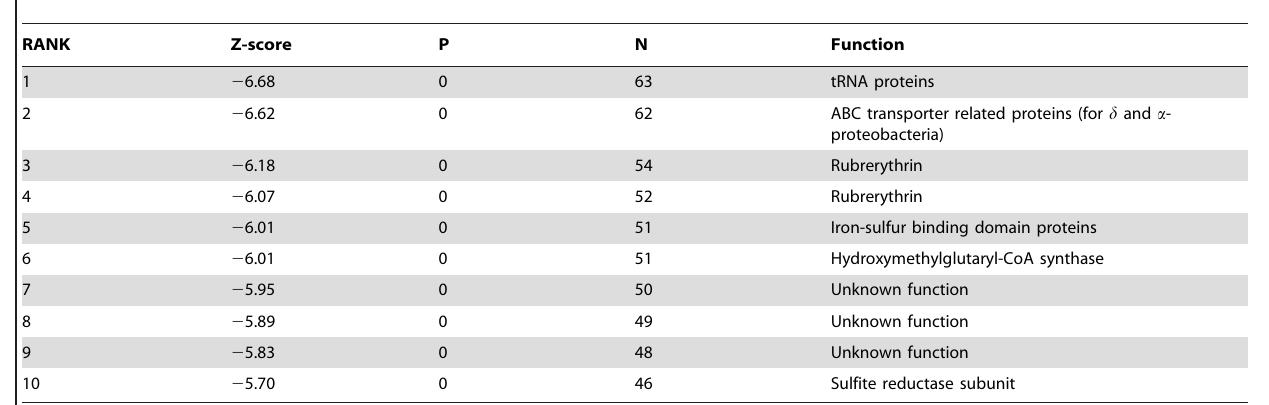
Table 6. Top 10 ranking non-pathogenic protein families and annotated functions of their proteins for the WDM model.